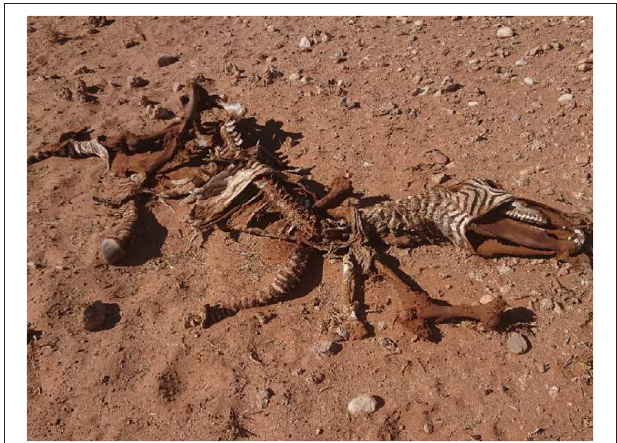
FIGURE 4 | Carcass of the anthrax positive mountain zebra which the cheetahs fed on < 24h prior to their death. The picture was taken during the first field inspection, 11 days after the estimated cheetah